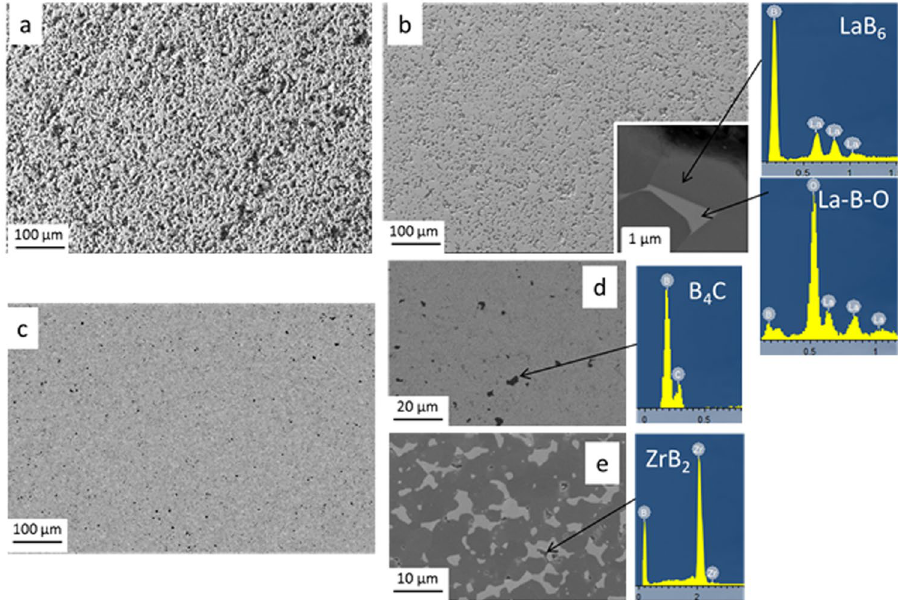
Figure 2. ( a ) Rough surface of porous LaB 6 in SE imaging, ( b ) polished surface of porous LaB 6 in SE imaging, Inset: high magnification of porous LaB 6 microstructure showing oxide phases (La 2 O 3 ) wetting the grain boundaries and relative EDS spectra, ( c ) polished surface of dense LaB 6 in SE imaging, ( d ) higher magnification details showing B 4 C pockets in BSE imaging; ( e ) ZrB 2 inclusion in LaB 6 matrix in-lens imaging ( d ) and corresponding EDS spectra.